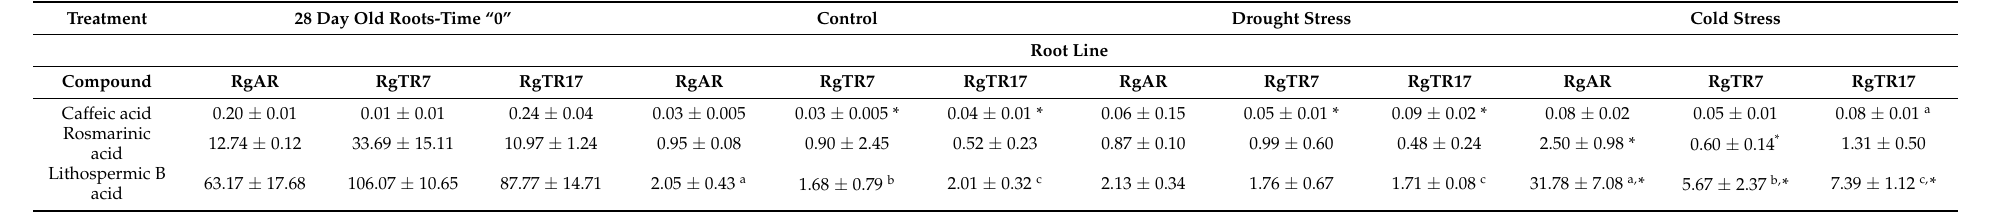
Table 4. Phenolic acid content [mg/g DW] in R. graeca roots cultivated under various conditions.